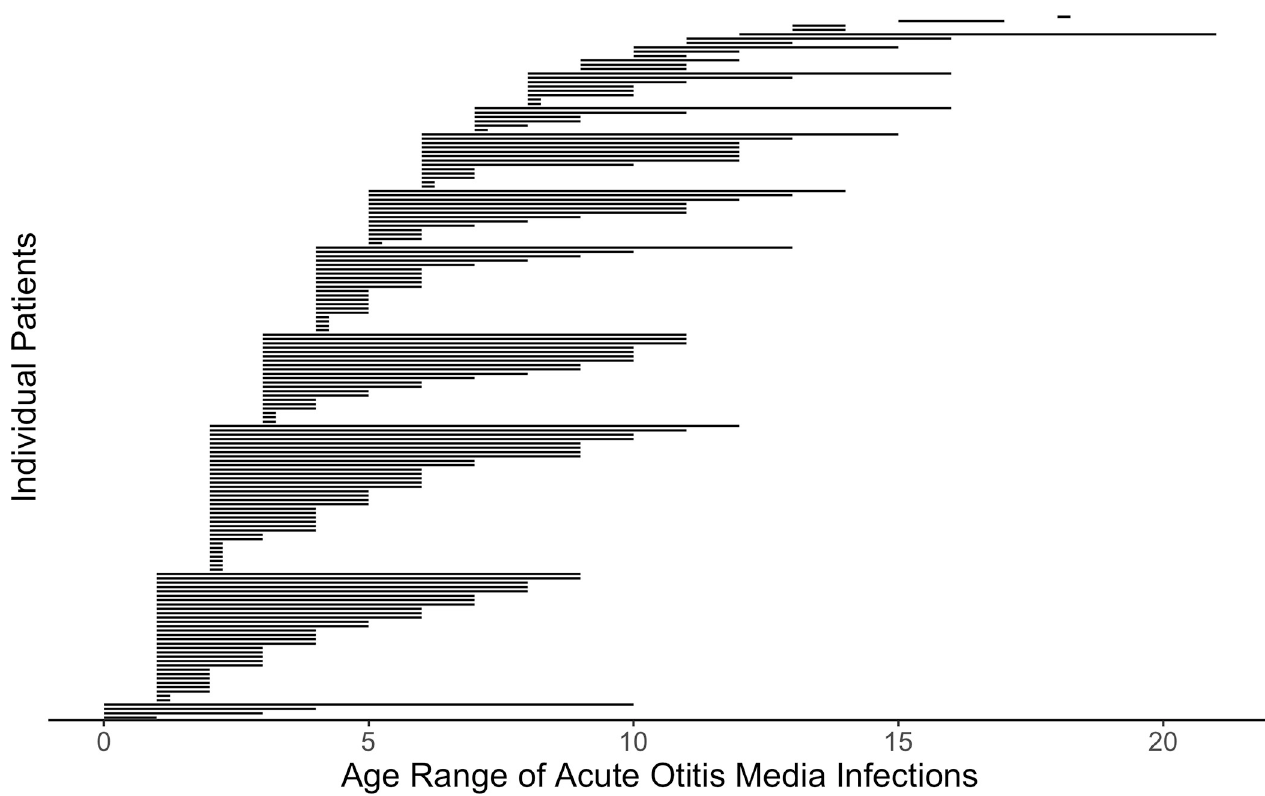
Fig 3. Age range of AOM infections. Each line represents an individual patient. N = 162 represents all patients who had at least one AOM infection.